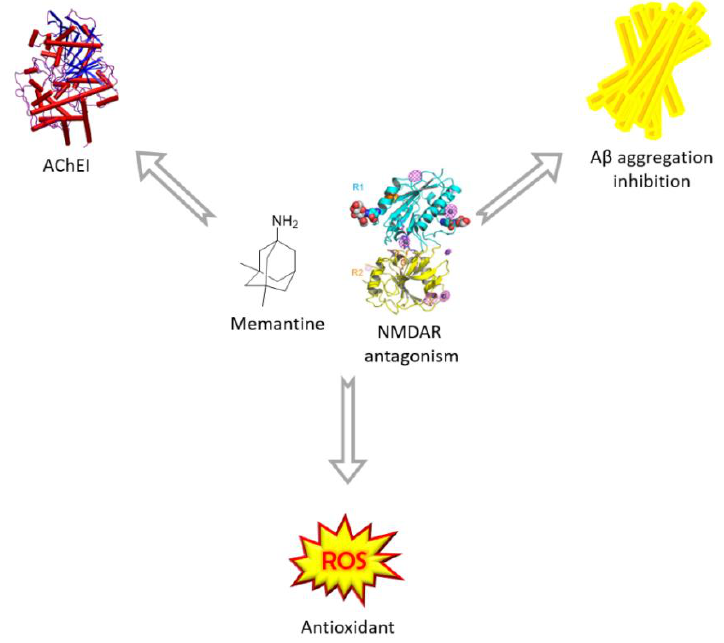
Figure 1. Conjugation strategies exploiting memantine’s NMDAR antagonism to tackle